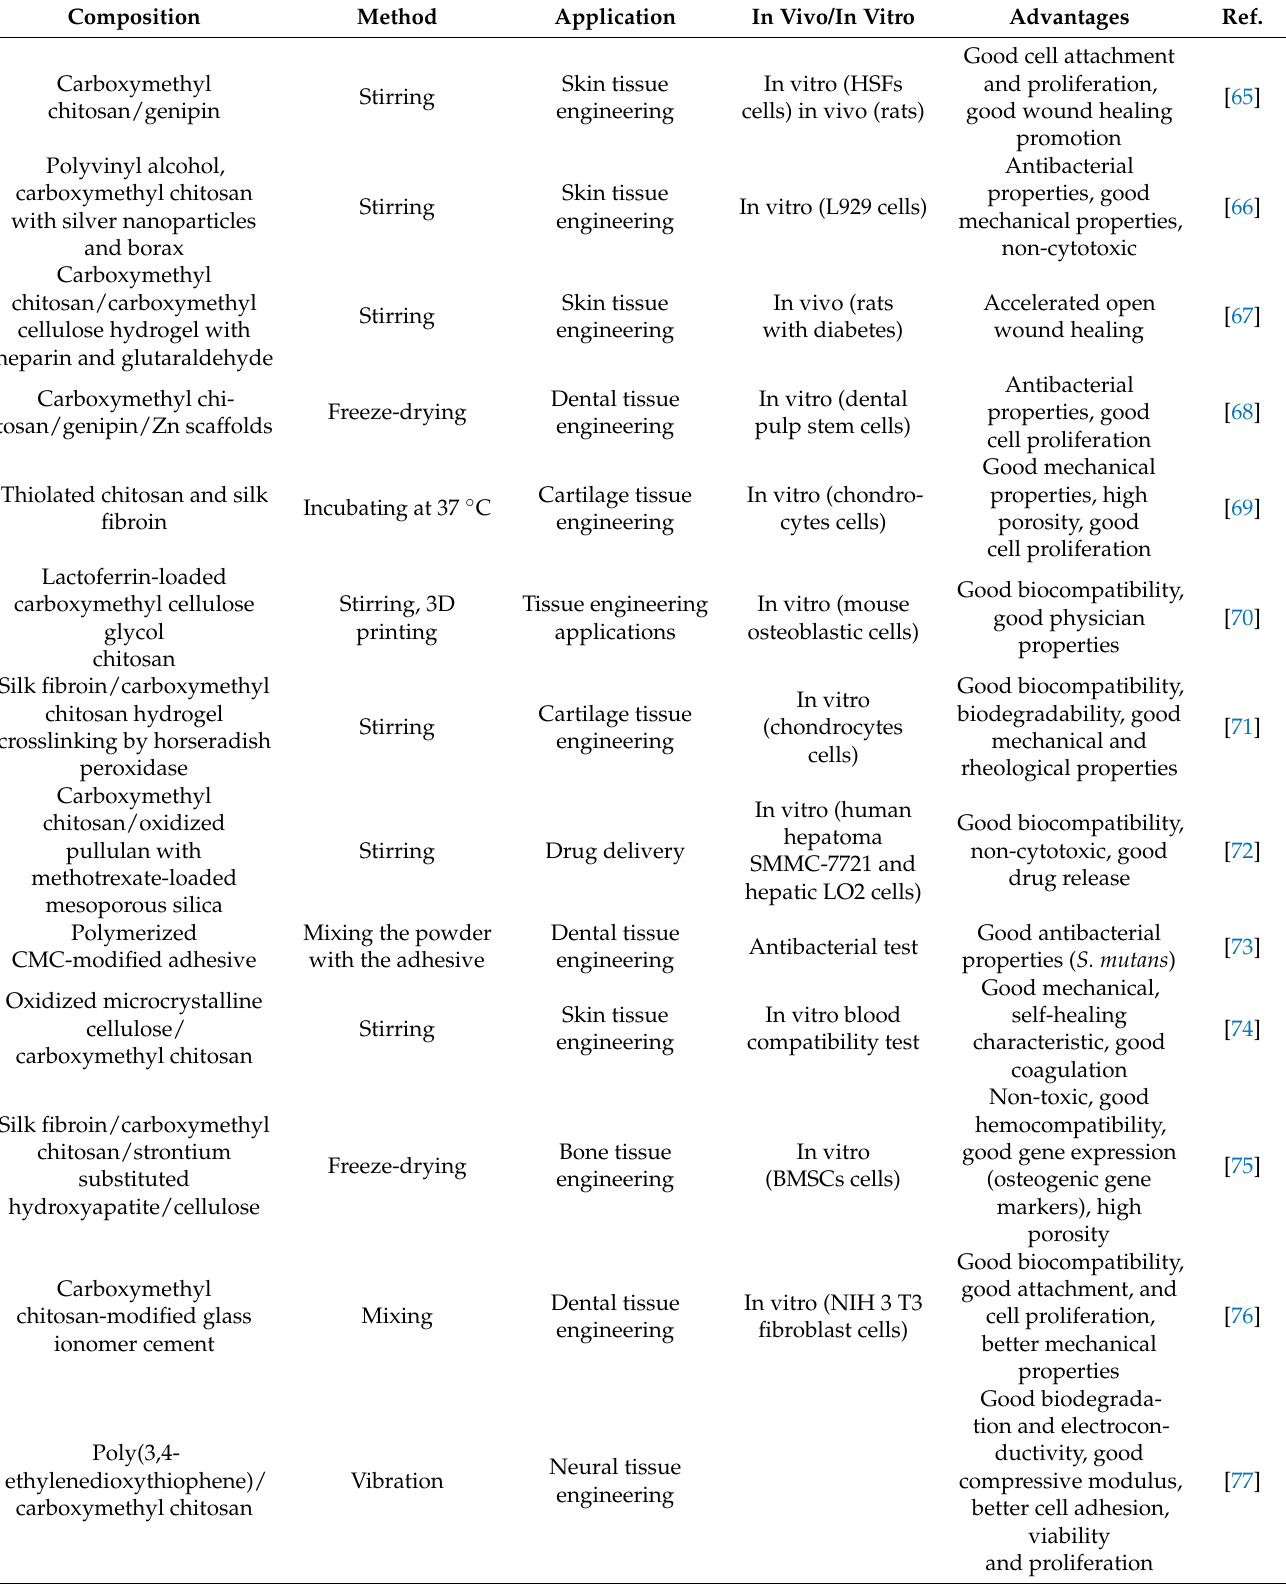
Table 2. Applications of chitosan-derivative-based materials in tissue